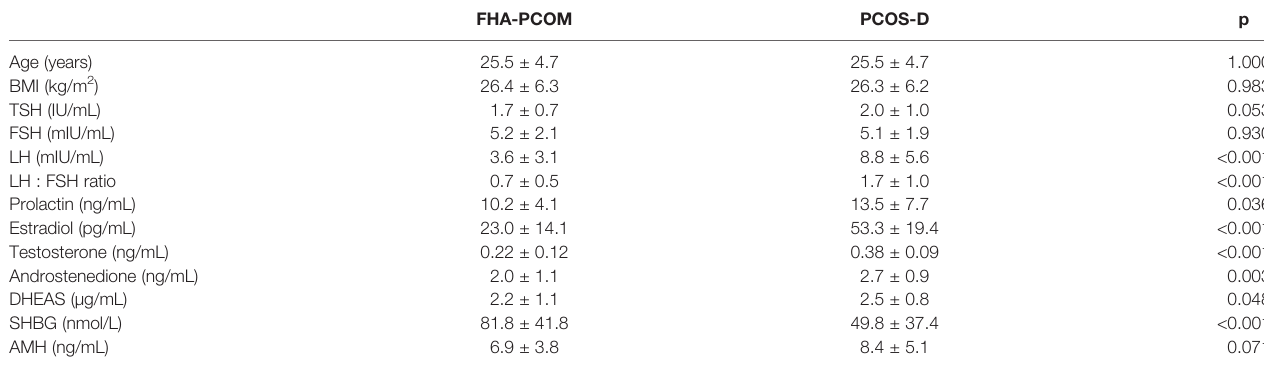
TABLE 1 | Basic patient characteristics and results of hormonal testing in FHA-PCOM and PCOS-D patients. Data are presented as mean ± SD. FHA-PCOM PCOS-D